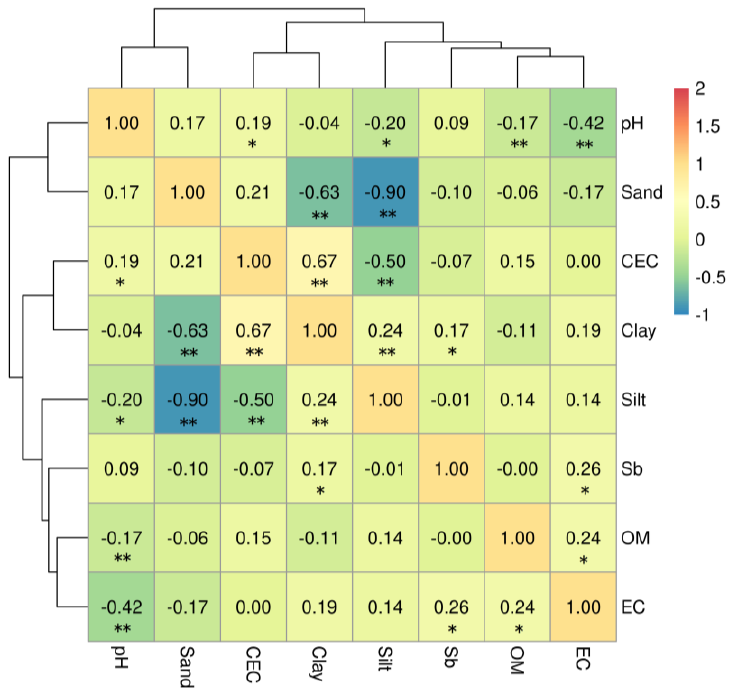
Figure 4. Heat map of correlation coefficients and clusters between Sb concentration and soil physicochemical properties. * represents p < 0.05 and ** represents p < 0.01.